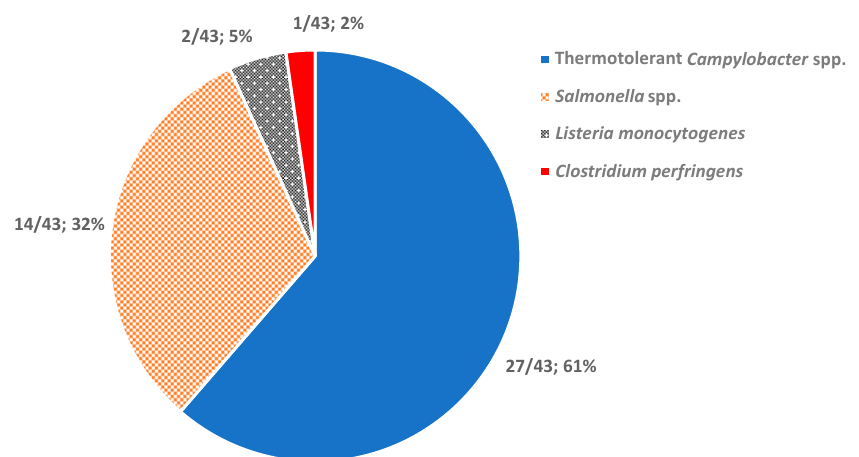
Figure 3. Pathogens included in review of QMRA studies. One paper [51] included QMRAs for both Salmonella spp. and thermotolerant Campylobacter spp., so it was counted twice.